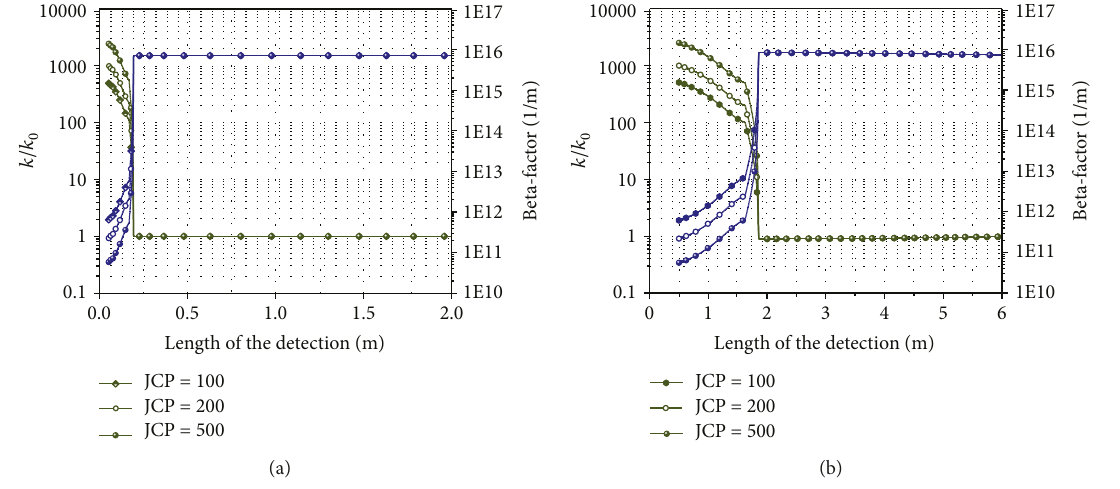
Figure 8: Permeability and β factor distributions around a